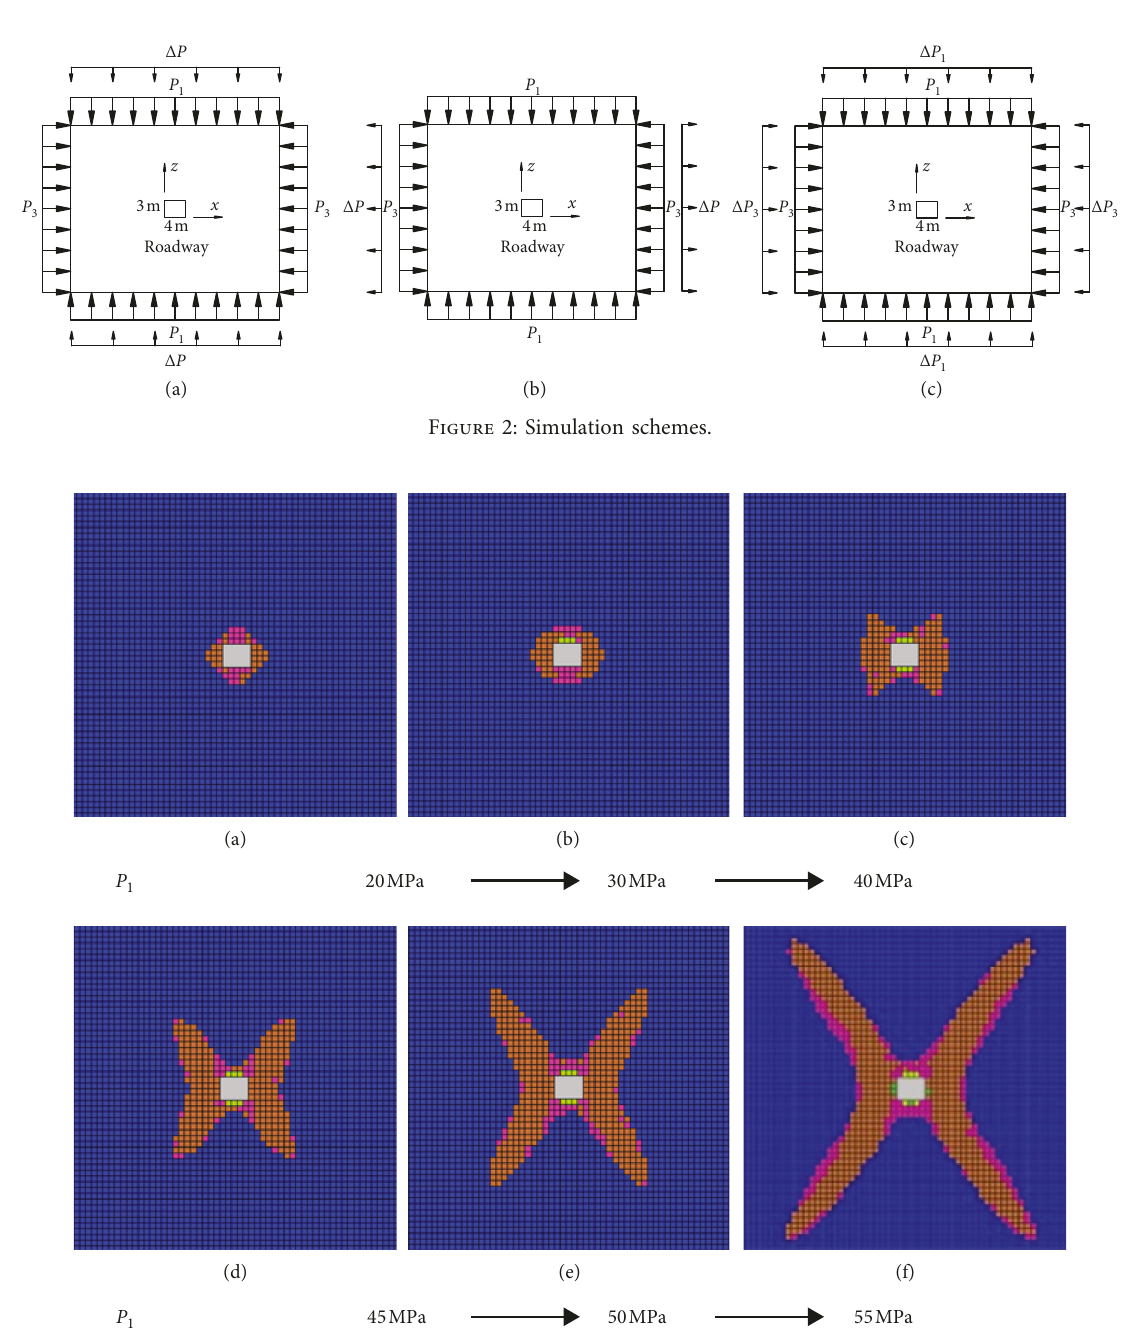
Figure 3: Evolution laws of the plastic zone loading in the direction of maximum confining pressure. (a) R (c) R max � 6.8m. (d) R max � 12.1m. (e) R max � 21.5m. (f) R max �